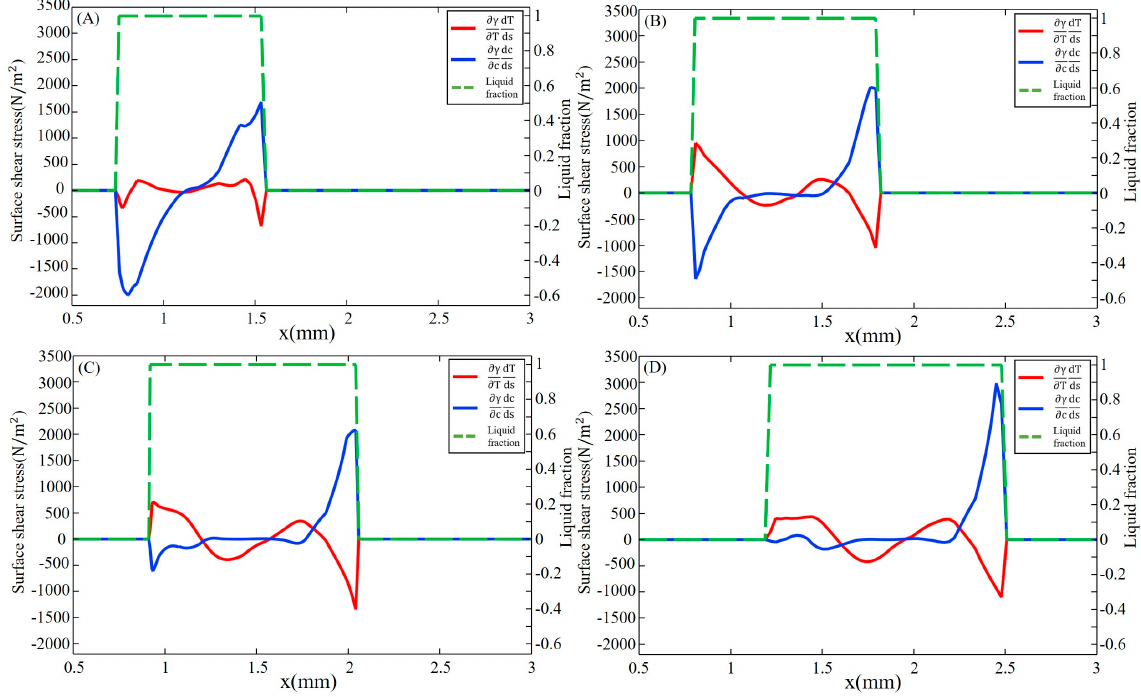
Figure 6. Surface shear stress in the longitudinal section with y = 0.2 mm on the Ni side at different times. ( A ) 10 ms; ( B ) 20 ms; ( C ) 30 ms; ( D ) 50 ms.